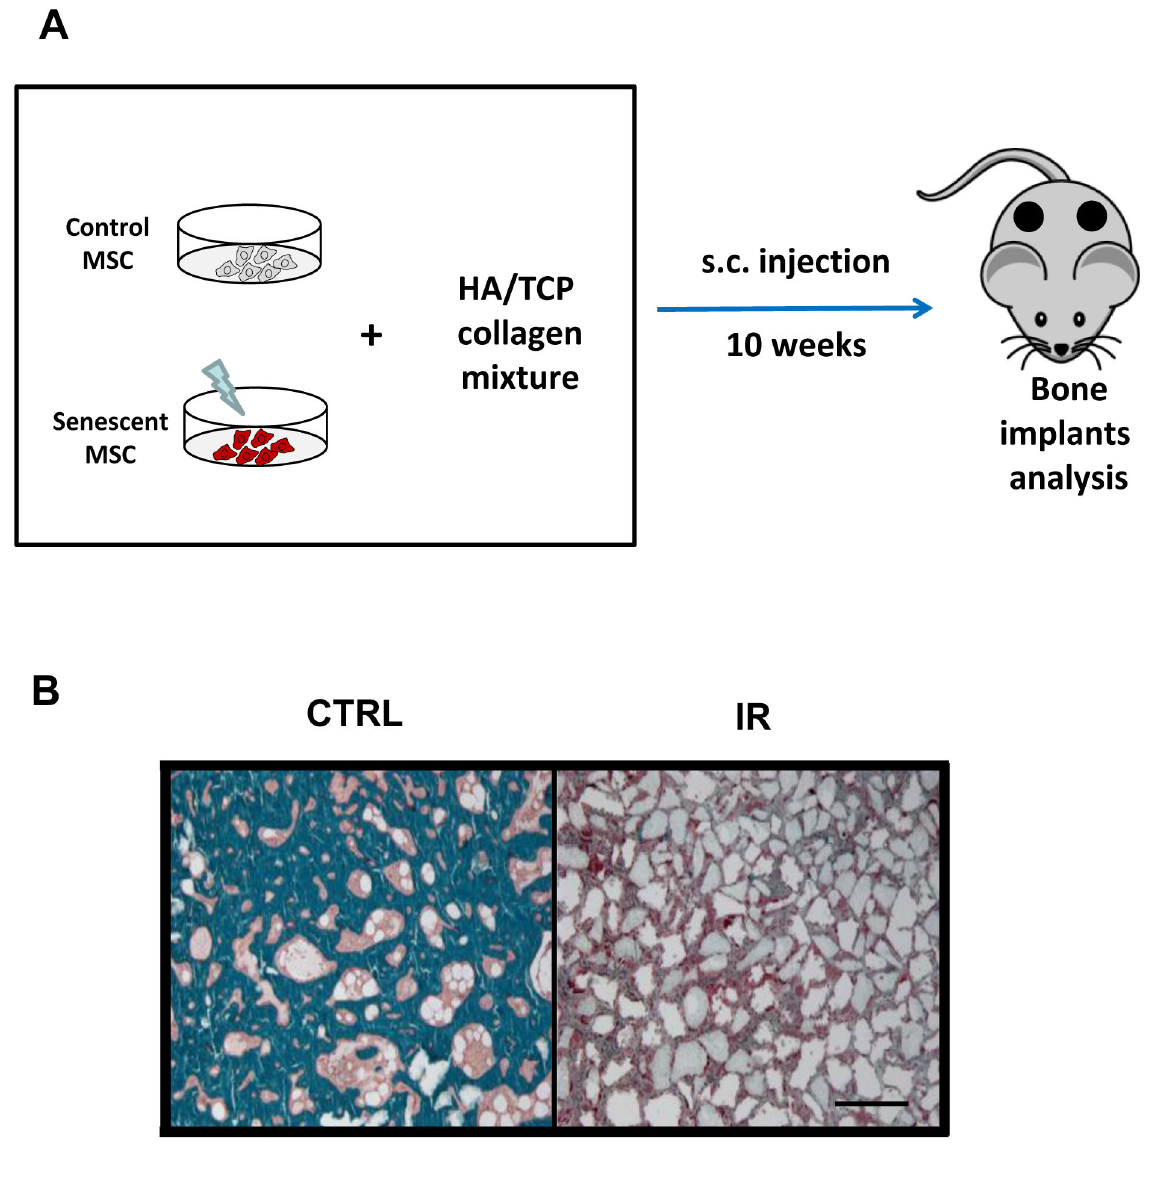
Figure 4. IR-induced senescent MSC failed to generate bone in vivo. ( A ) Schematic of the experiment. Control or IR-induced senescent MSC were mixed with HA/TCP particles along with collagen and injected subcutaneously to the flank of mice. 10 weeks post injection, implants were retrieved from the animals, embedded in plastic, sectioned and stained with Goldner’s trichrome to detect bone formation. (B) Representative images from n= 6 implants per group showing mineralization (Goldner’s trichrome in green) from control or IR-induced senescent MSC. Implants were counterstained with hematoxylin eosin. Scale bar: 300µm. doi: